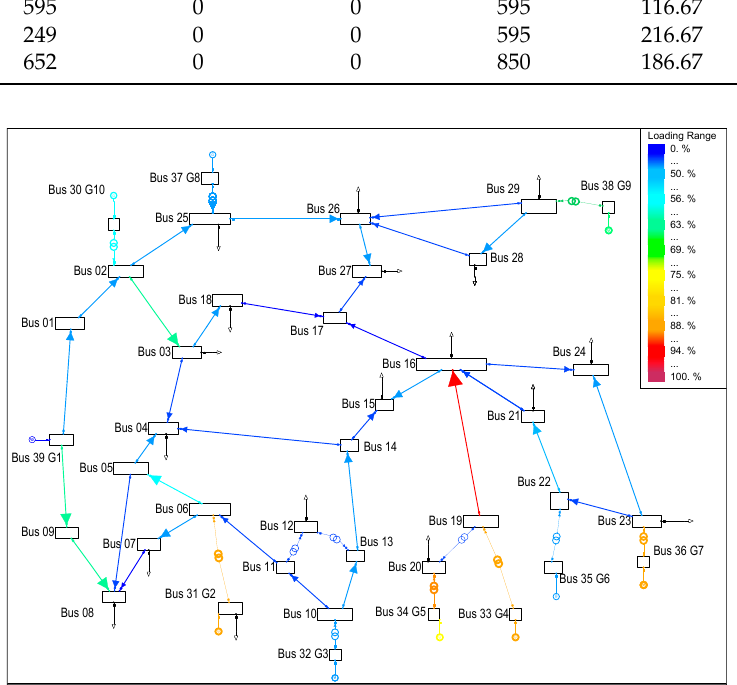
Loading Range 0. % ...